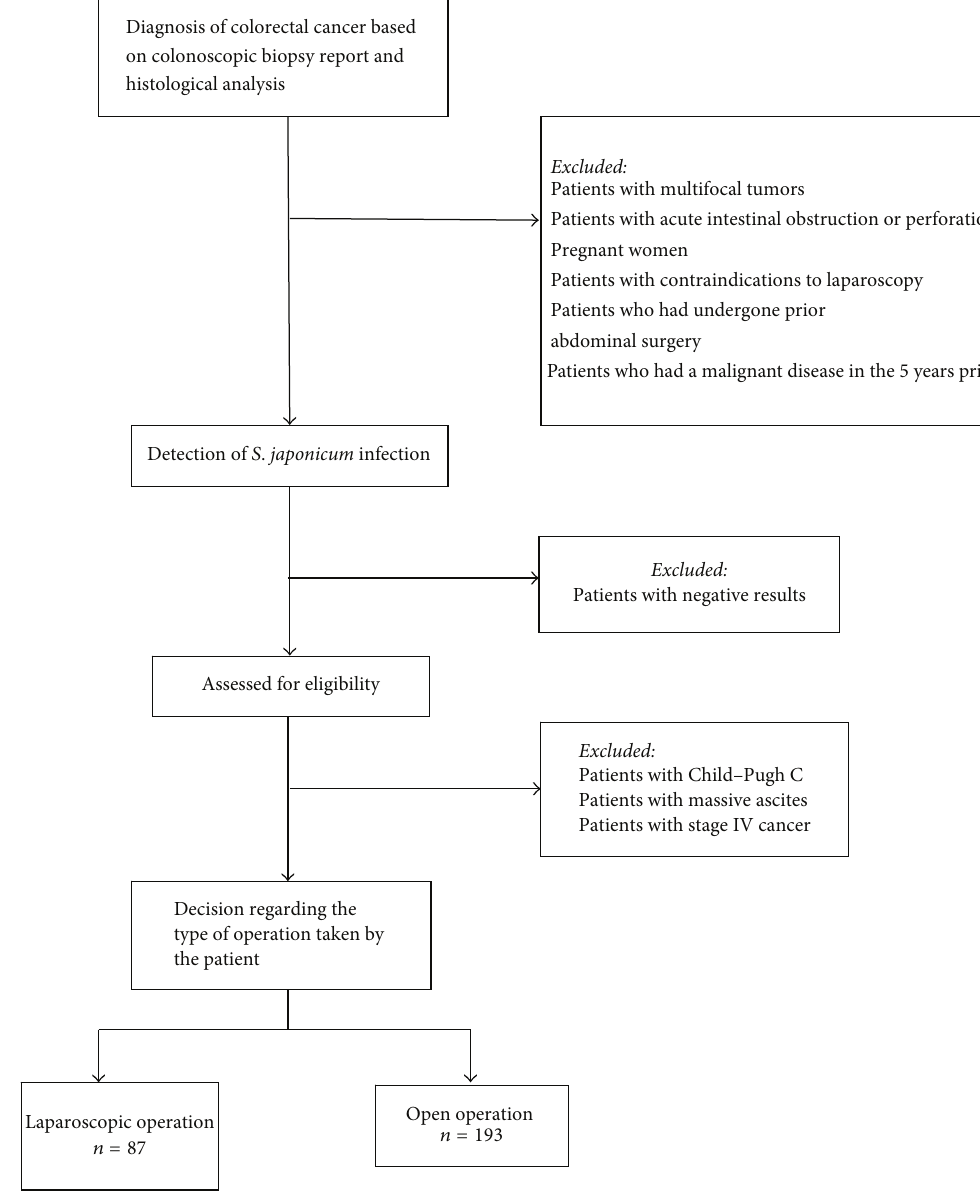
Figure 1: Flowchart of patient